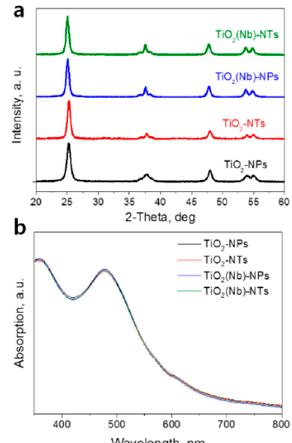
Figure 1. ( a ) X-ray di ff raction (XRD) patterns of pristine and Nb-doped TiO 2 nanoparticles (NPs)- and nanotubes (NTs)-based films. ( b ) Optical absorption spectra of N3 dye desorbed from the pristine and Nb-doped TiO 2 NPs- and TiO 2 NTs-based photoelectrodes.